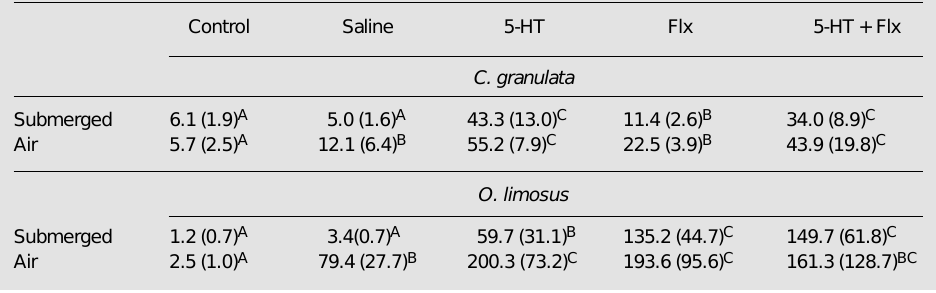
Table 1 - Effects of serotonin (5-HT), fluoxetine (Flx) and a mixture of both drugs (5-HT + Flx) on glucose levels (mg/100 ml hemolymph) in Chasmagnathus granulata and Orconectes limosus hemolymph. Animals were either kept submerged or exposed to atmospheric air after drug administration. Note that control animals were always kept submerged. Data are reported as mean ± SD. N = 5-8 animals in all cases. Same letters along a line indicate means not significantly different (P>0.05, ANOVA followed by Tukey multiple range test).